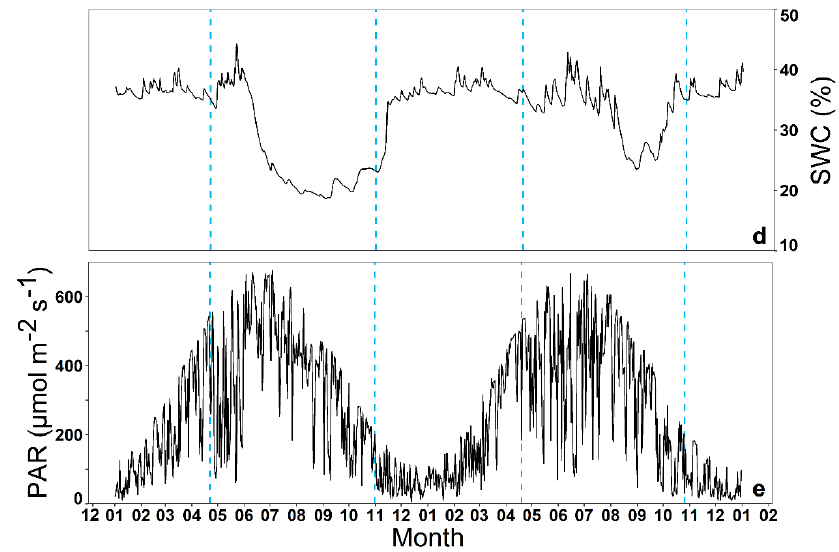
Figure 1. Daily dynamics of meteorological conditions during the 2019–2020 period. Air tempera- ture ( a ), precipitation ( b ), vapour pressure deficit ( c ), soil water content ( d ) and photosynthetic ac- tive radiation ( e ). The vertical blue dashed lines represent the borders of analysed periods for evap- otranspiration partitioning.